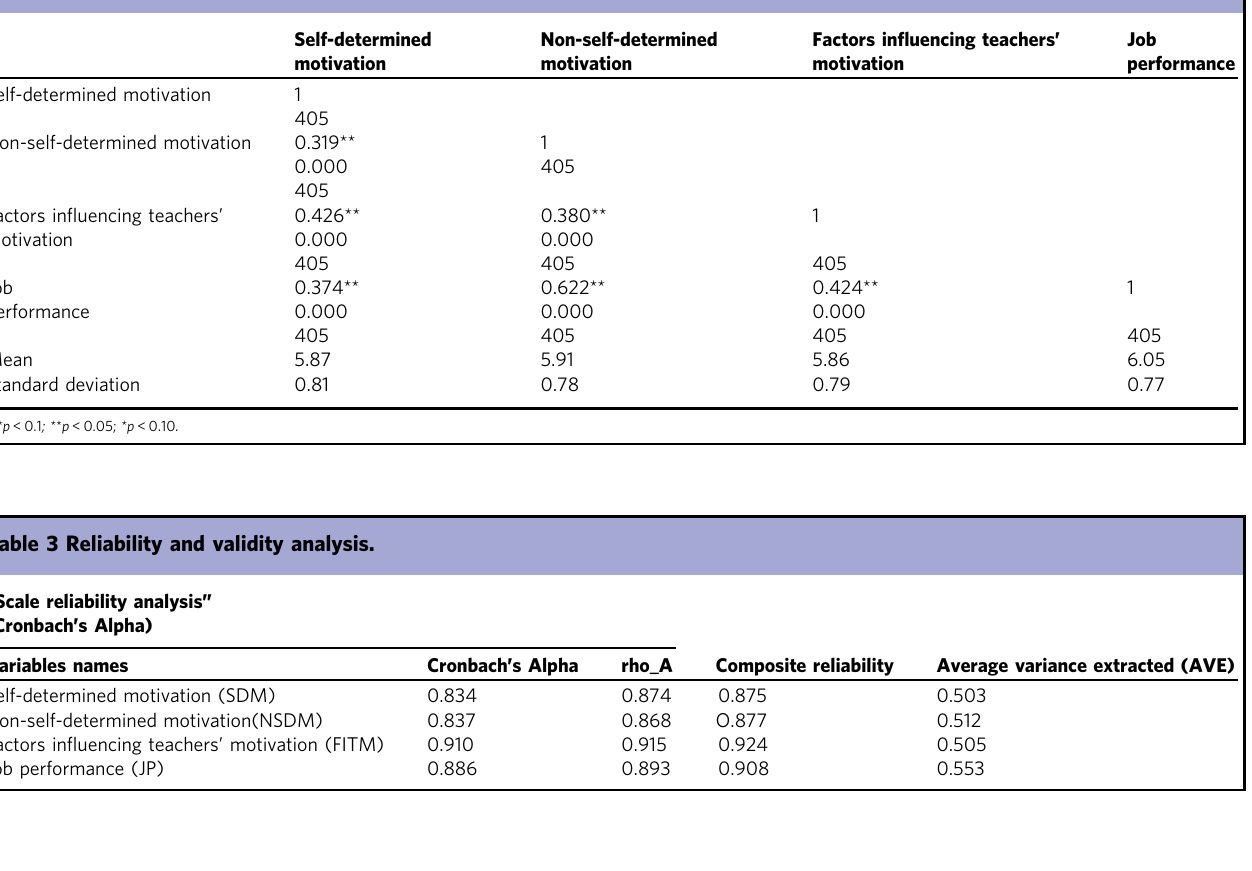
Table 2 Descriptive statistics and correlation.